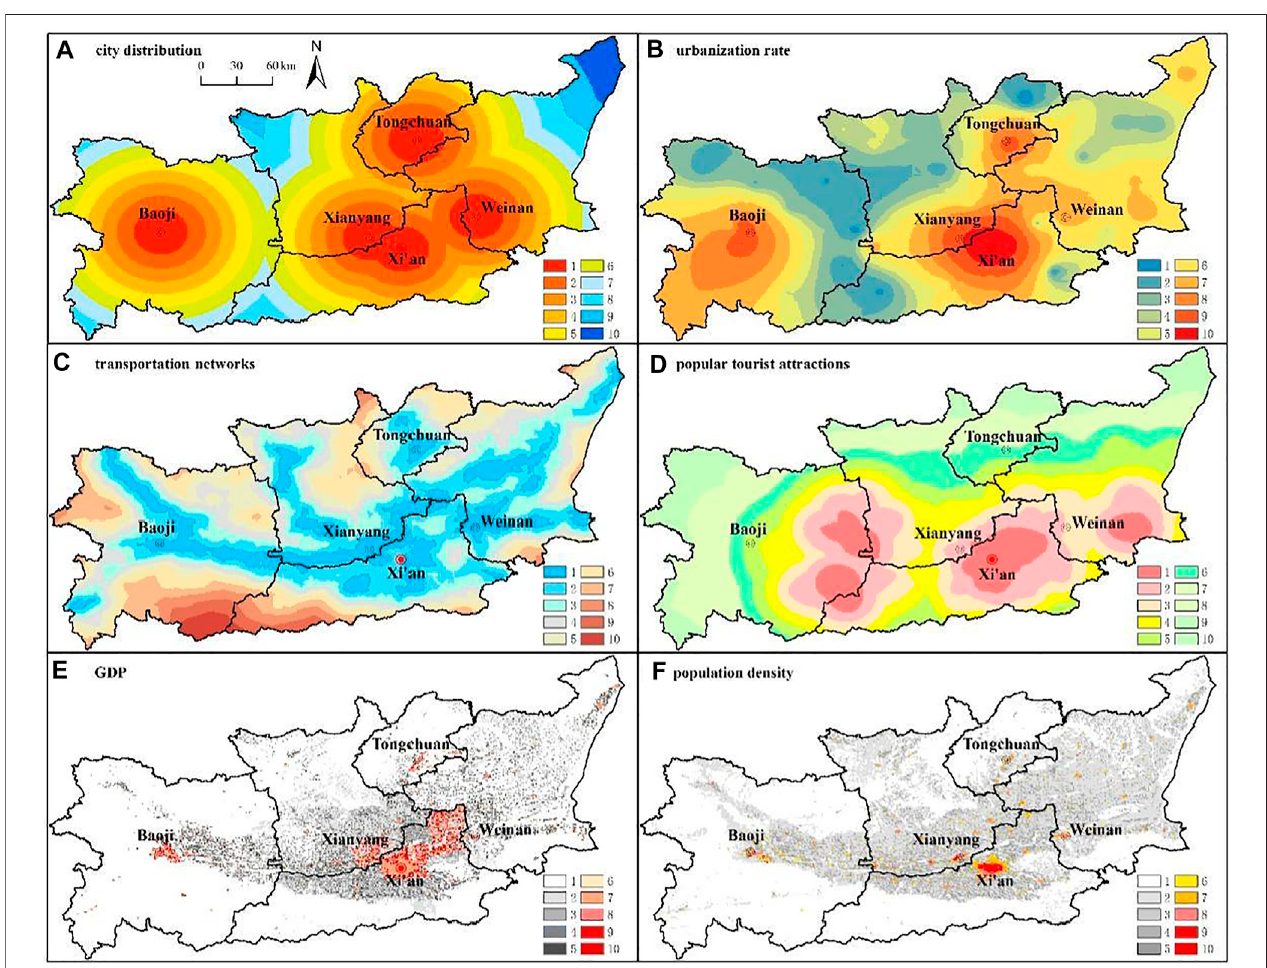
FIGURE 2 | Results of reclassi fi cation of factor data for Guanzhong, Central China showing distributions of (A) cities, (B) urbanization rate, (C) transportation networks, (D) popular tourist attractions, (E) Gross Domestic Product (GDP), (F) population density.